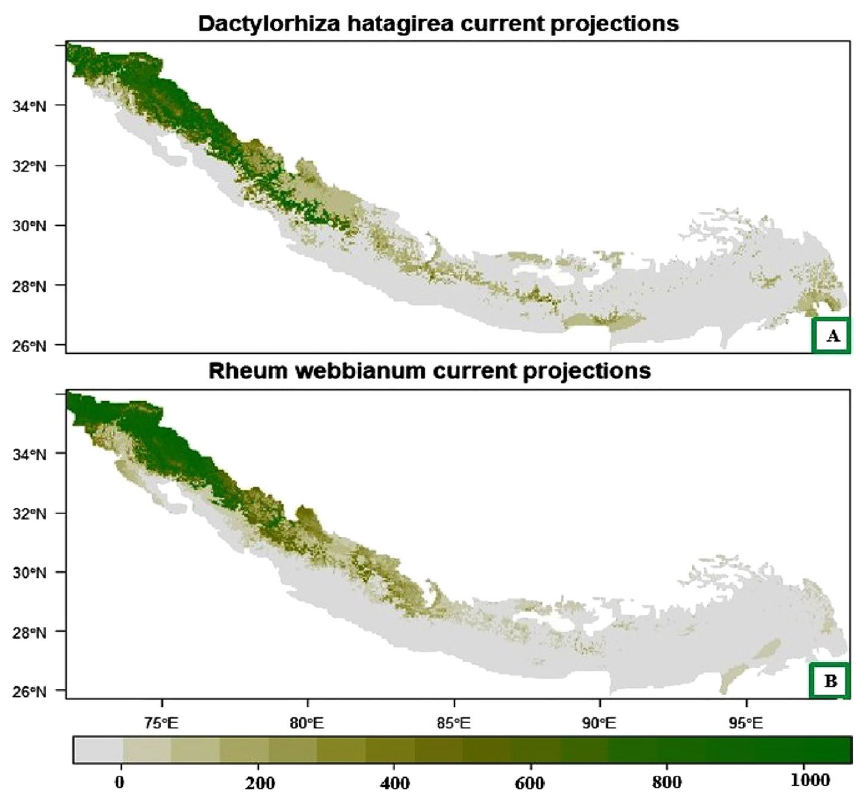
Figure 3. Plot showing the geographic projections of ensemble models for ( A ) Dactylorhiza hatageria and ( B ) Rheum webbianum under current climatic conditions. The habitat appropriateness class is represented by a scale ranging from 0 to 1000, with 0 denoting the absence of the species, 200–400 represent the habitats with least suitability, 400–600 denoting marginally suitable areas, 600–800 denoting moderately suitable areas, and 800–1000 represent the areas with extremely high habitat